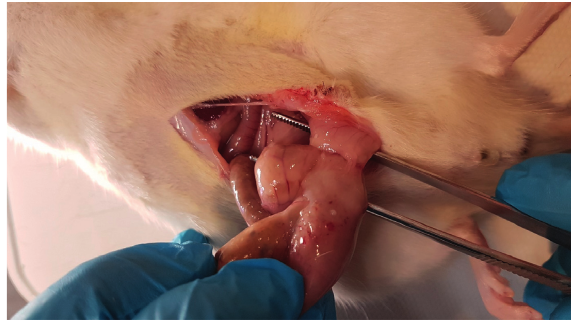
Figure 4: Macroscopic adhesion score 3 case from the control group.